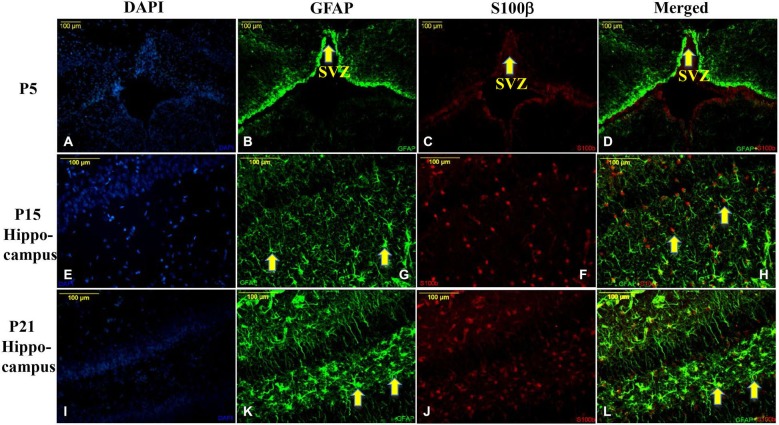
Dual immunofluorescence staining with GFAP and S100β reveal the association of S100β with mature astrocytes. DAPI (blue; A,E,I), GFAP (green; B,G,K) and S100β (red; C,F,J). The astrocyte population increases further from P5 to P21 as revealed by GFAP staining (B,G,K). S100β expression was detected in the SVZ at P5 but was found to be associated with the GFAP+ astrocytes at P15 and P30 in hippocampus. The merged images indicate no incidence of co-labeling throughout the period of study (D,H,L). In mature astrocytes the S100β expression was located in the cell soma while GFAP in the processes (H,L).